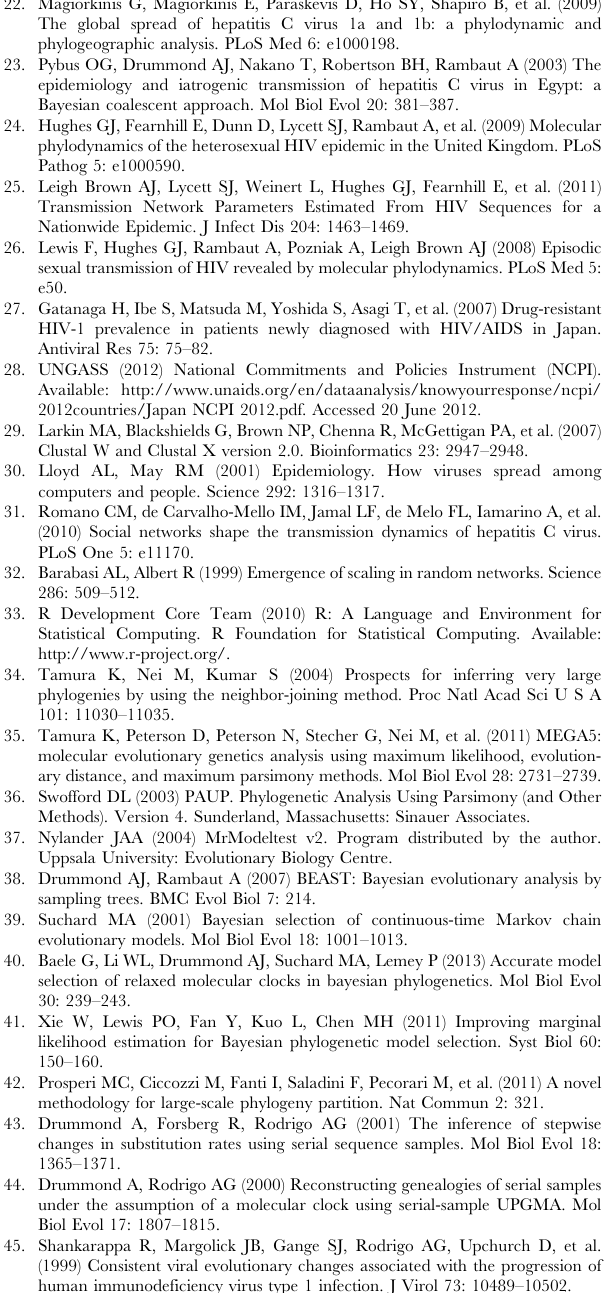
Table S5 Evolutionary parameters obtained in Bayes- ian MCMC inference with constant size and lognormal